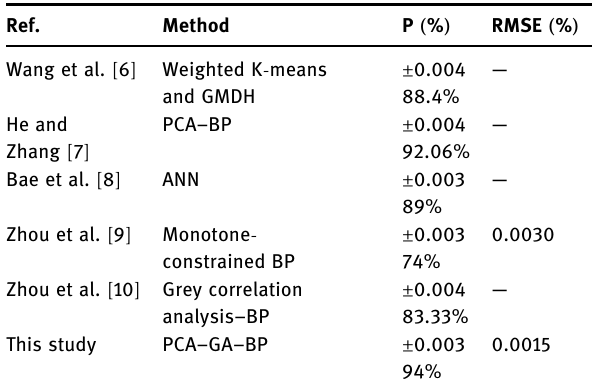
Table 6: Comparison of prominent methods, deviations, hit